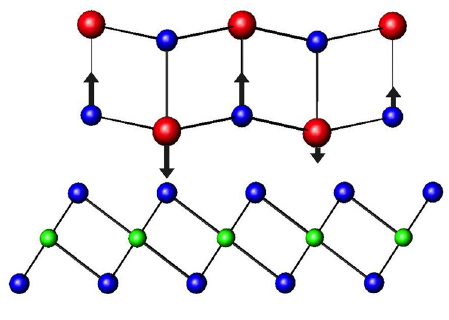
Figure 4. Two-dimensional representation of modulation in the a -direction and the resulting changes in local environment. The black arrows represent coulombic interactions expected based on proximity to X atoms in the adjacent TX 2